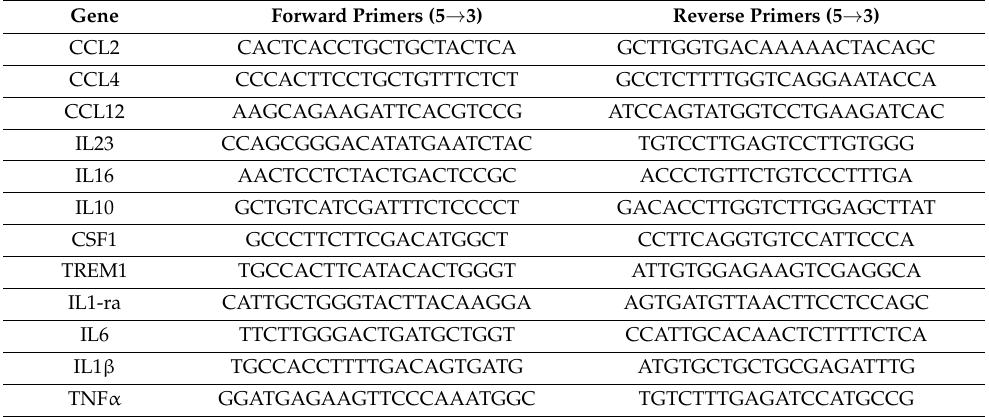
Table 1. Primer sequences for